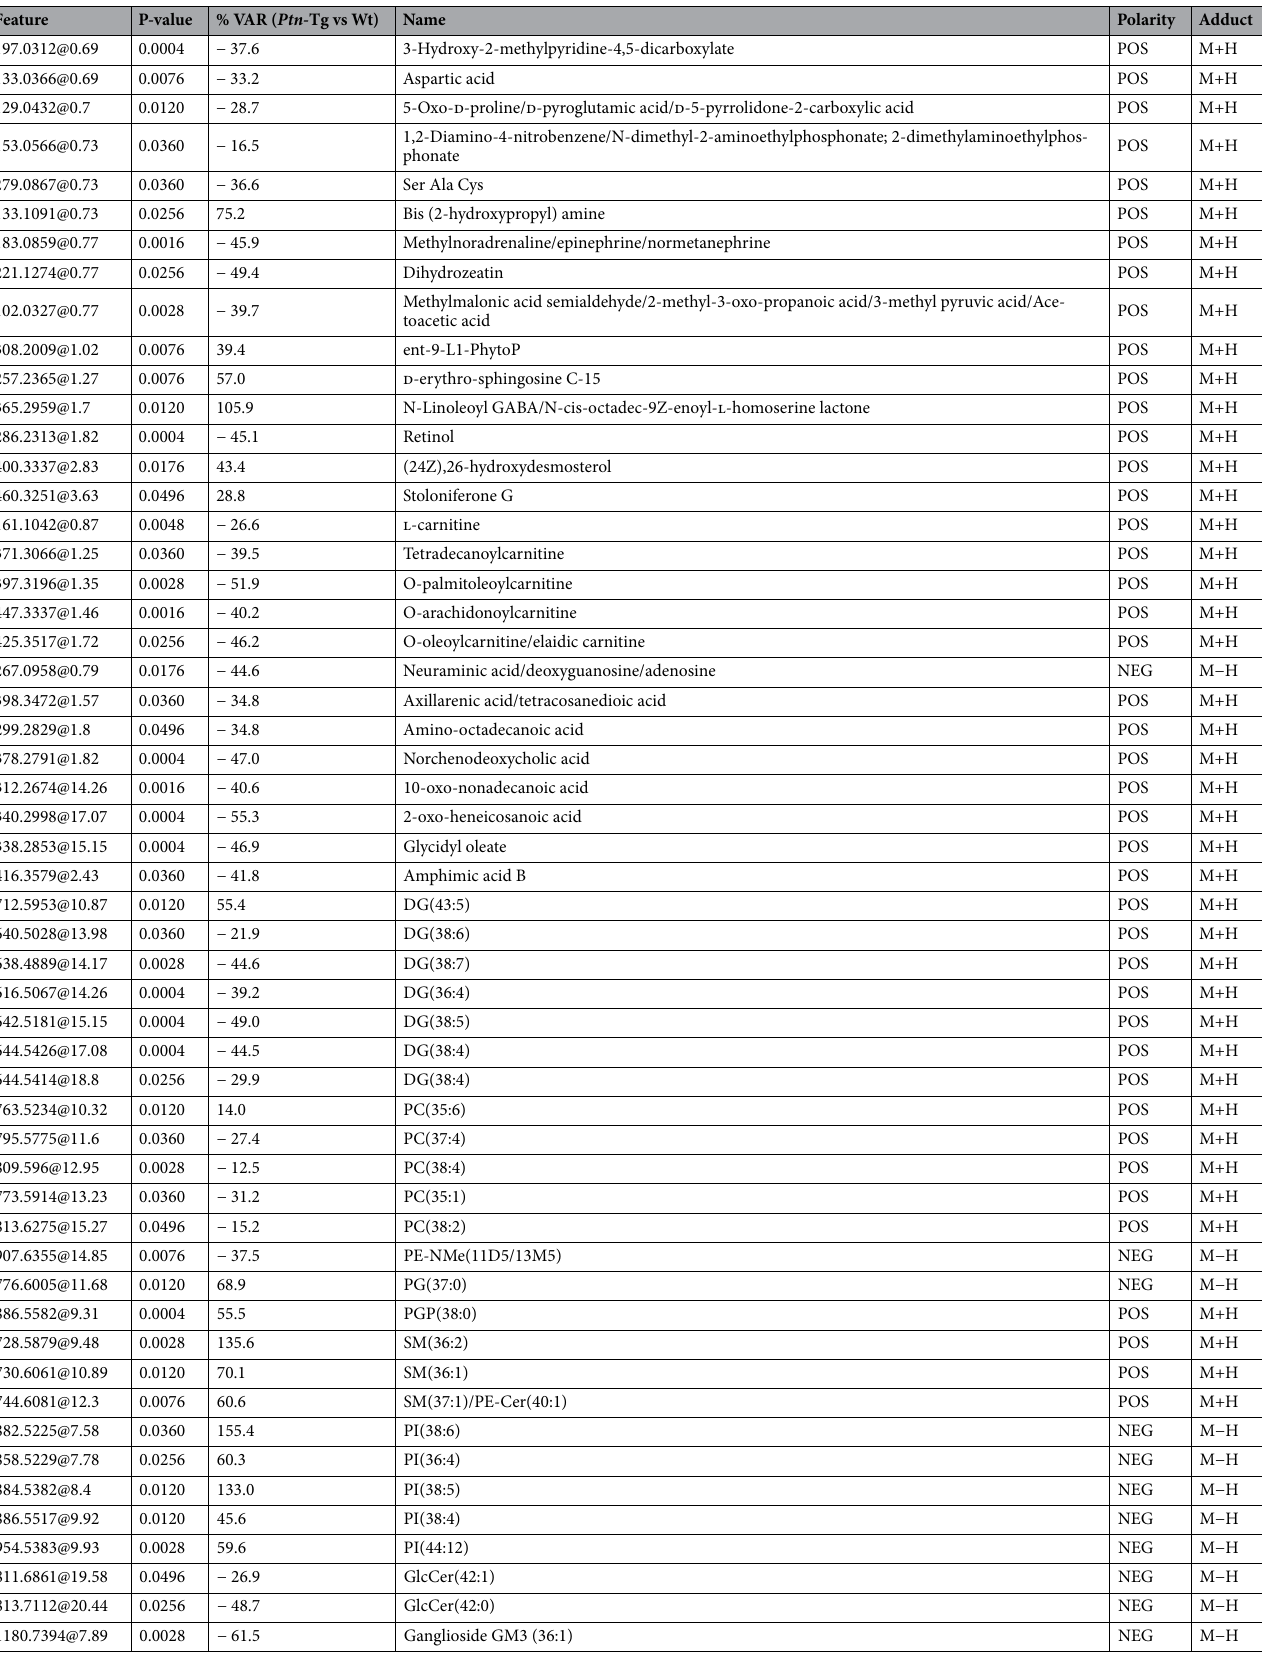
Table 2. Metabolites found to be significant between vehicle-injected Ptn -Tg mice and vehicle-injected Wt